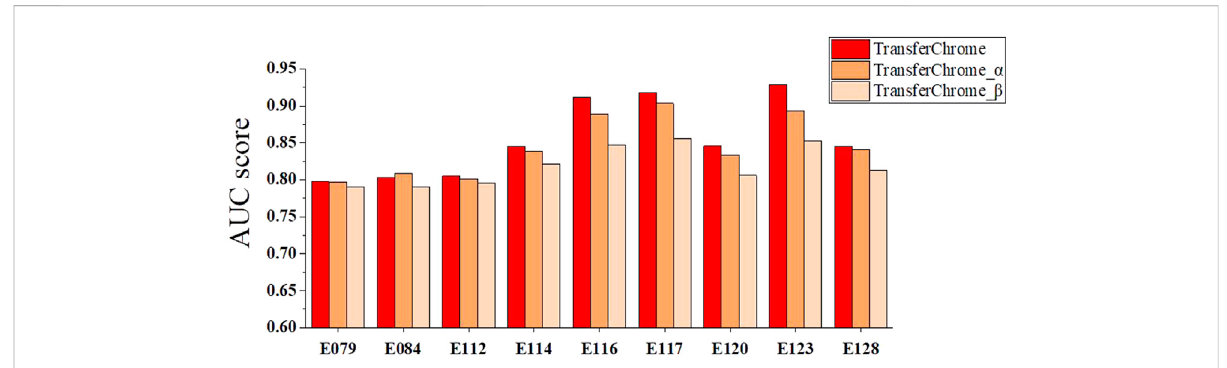
FIGURE 5 The performance comparison of different versions of TransferChrome: TransferChrome, TransferChrome_ α and TransferChrome_ β on 9 cell lines (E079, E084, E112, E114, E120, E128, E116, E117,